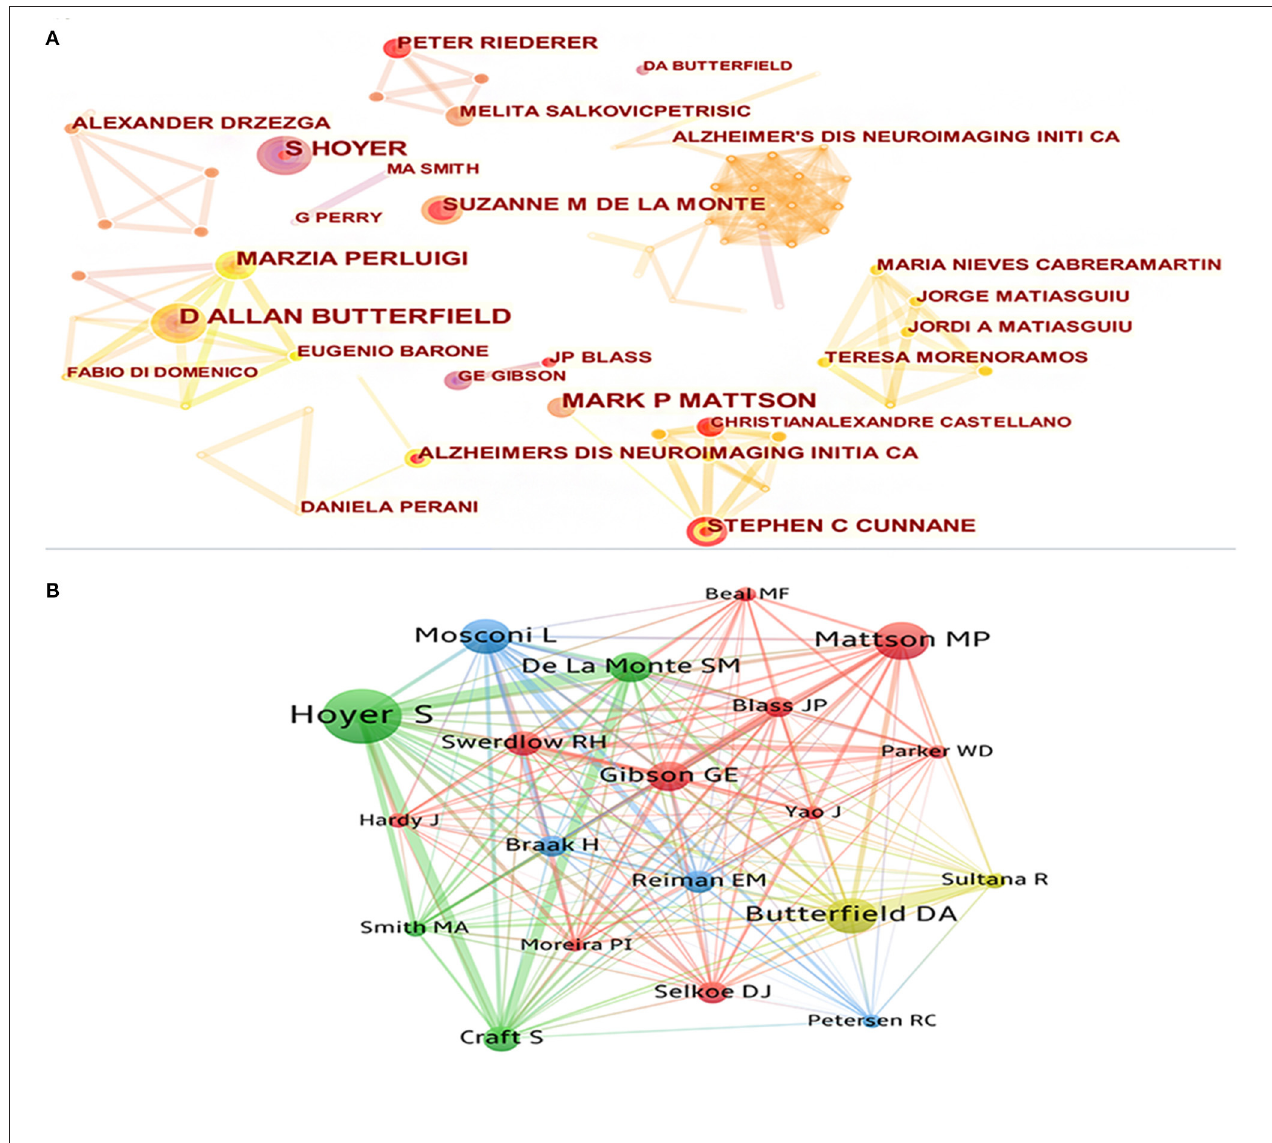
FIGURE 5 | (A) The cooperation network visualization map of authors based on CiteSpace; (B) The co-citation network visualization map of authors based on VOSviewer.